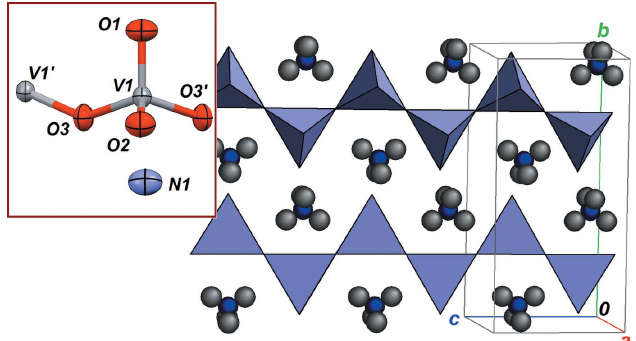
Figure 1 Part of the crystal structure of ammonium metavanadate, viewed approximately down [100], using a polyhedral representation for the vanadate chains and spheres of arbitrary radii for ammonium cations (Boudias & Monceau, 1998). The inset shows non-H atoms with displacement ellipsoids at the 80% probability level. The V1 0 and O3 0 sites are generated by the symmetry operations x , 1 respectively.